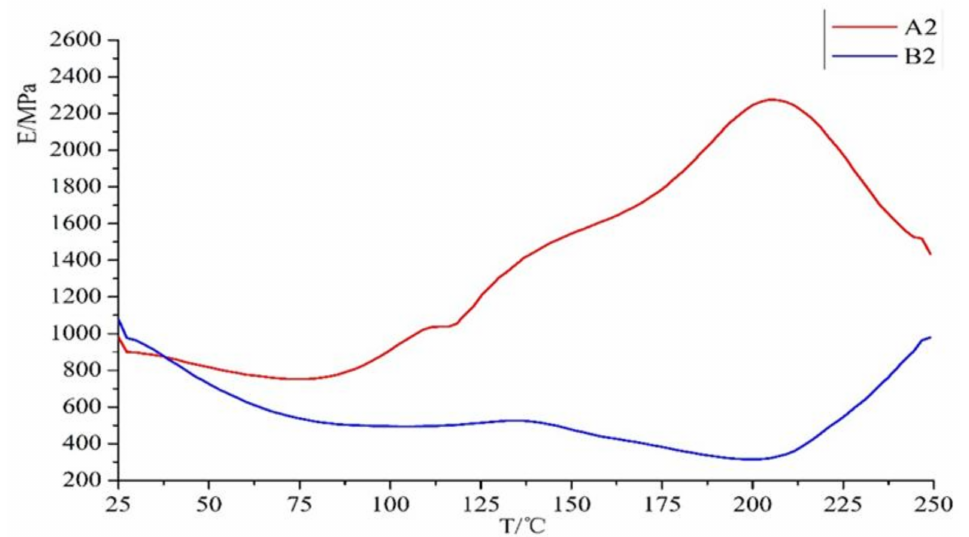
Figure 21. Comparative themomechanical analysis (TMA) traces of curing of A2 and B2 NIPU resins on